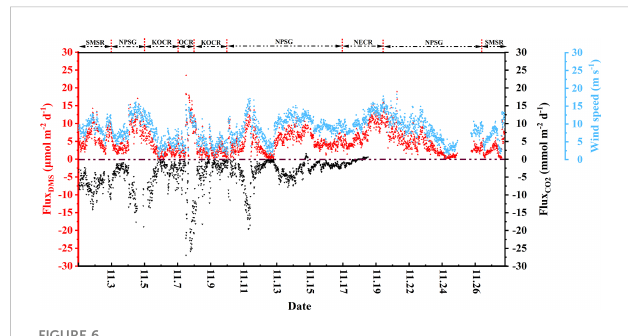
FIGURE 6 Time series of DMS and CO 2 sea-air fl uxes with wind speed in the Northwest Paci fi c